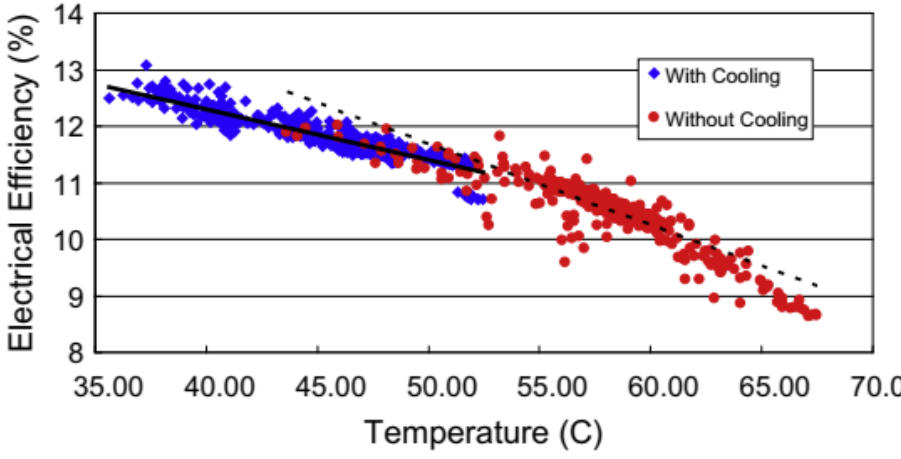
Figure 1. The relationship between solar cell efficiency and temperature [10]. Adapted with permission from Elsevier.